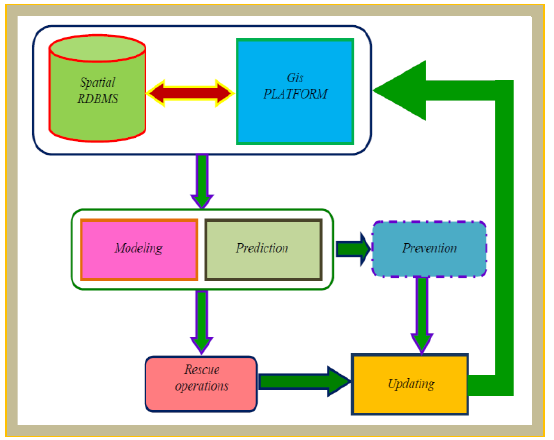
Figure 1. Architecture of a GIS-based DSS for emergency prevision and management.